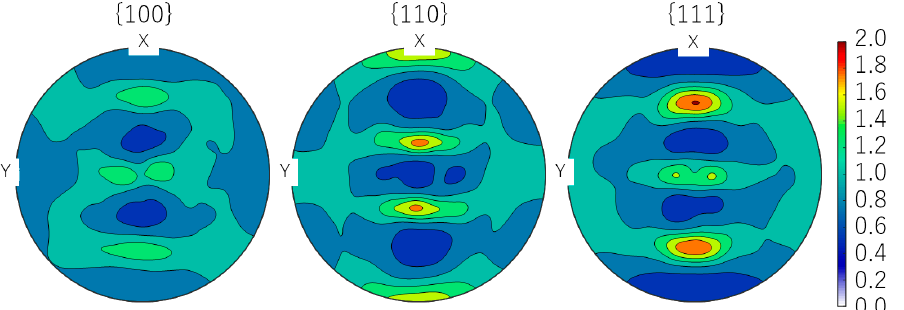
Figure 1. {100}, {110}, and {111} pole figures showing the initial texture of the tested steel. The directions X (vertical), Y (horizontal), and Z (vertical to the paper) correspond to RD (rolling direction), TD (transverse direction), and ND (normal direction) in the hot ‐ rolling process, respectively.